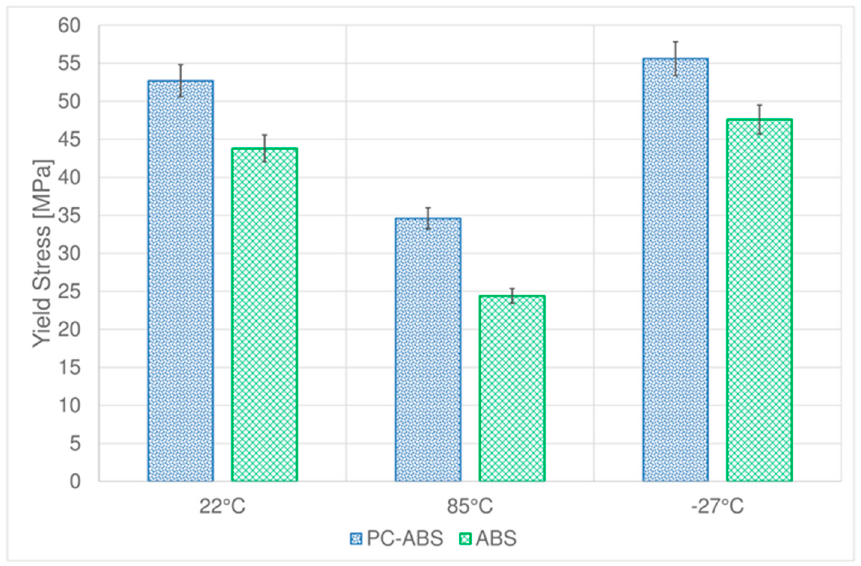
Figure 6. Comparison between yield stresses of PC-ABS and ABS at different temperatures.